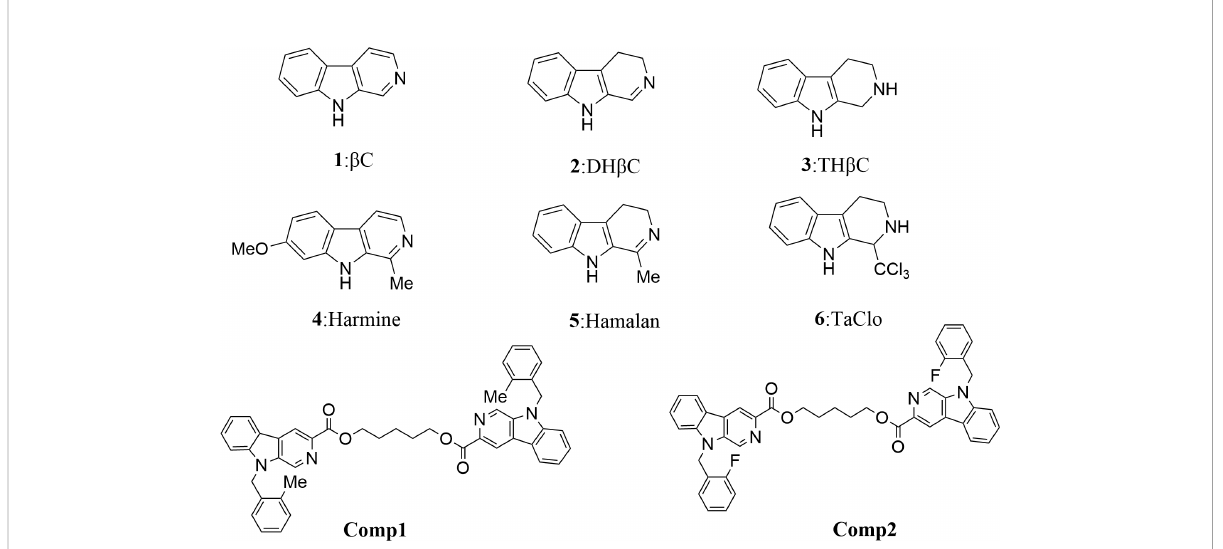
FIGURE 1 Structures of simple tricyclic b - carboline and b - Carboline-3-carboxylic acid dimers. Comp1:pentane-1,5-diyl-bis-(9-(2-methylbenzyl)-9H- pyrido[3,4-b]indole-3-carboxylate. Comp2:pentane-1,5-diyl-bis-(9-(2- fl